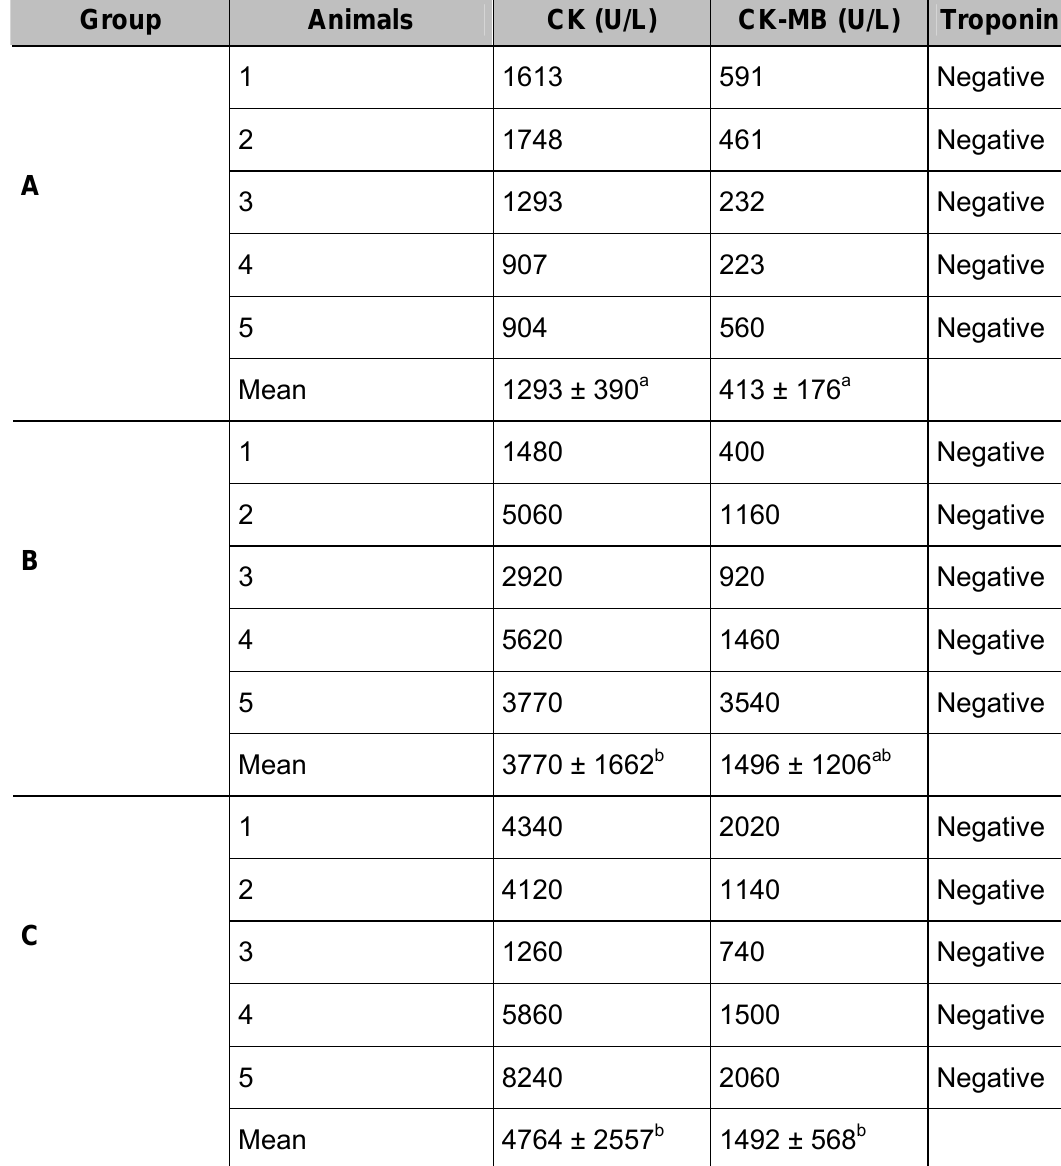
Mean values (± standard error) are shown for the five animals in each group. Within each column, mean values followed by different lowercase letters are significantly different at P < 0.05 according to analysis of variance and SNK